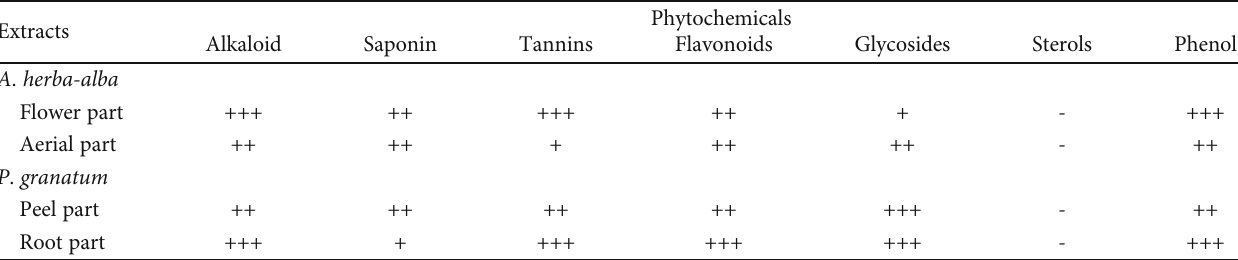
Table 1: Phytochemical constituents of investigated plant extracts.